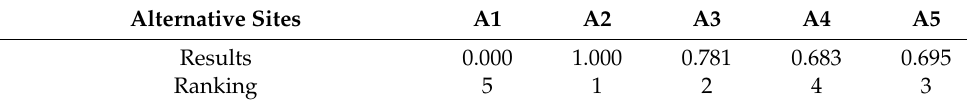
Table 3. Site selection